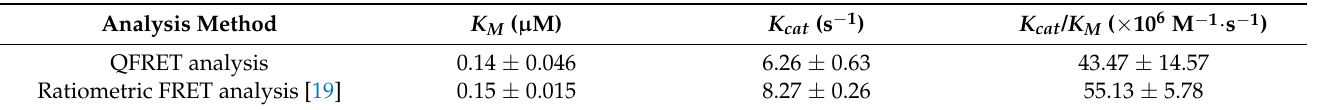
Table 3. Kinetic parameters of SUMO1-RanGAP1C deconjugation by SENP1C determined by qFRET analysis and compared to those derived from ratiometric FRET analysis